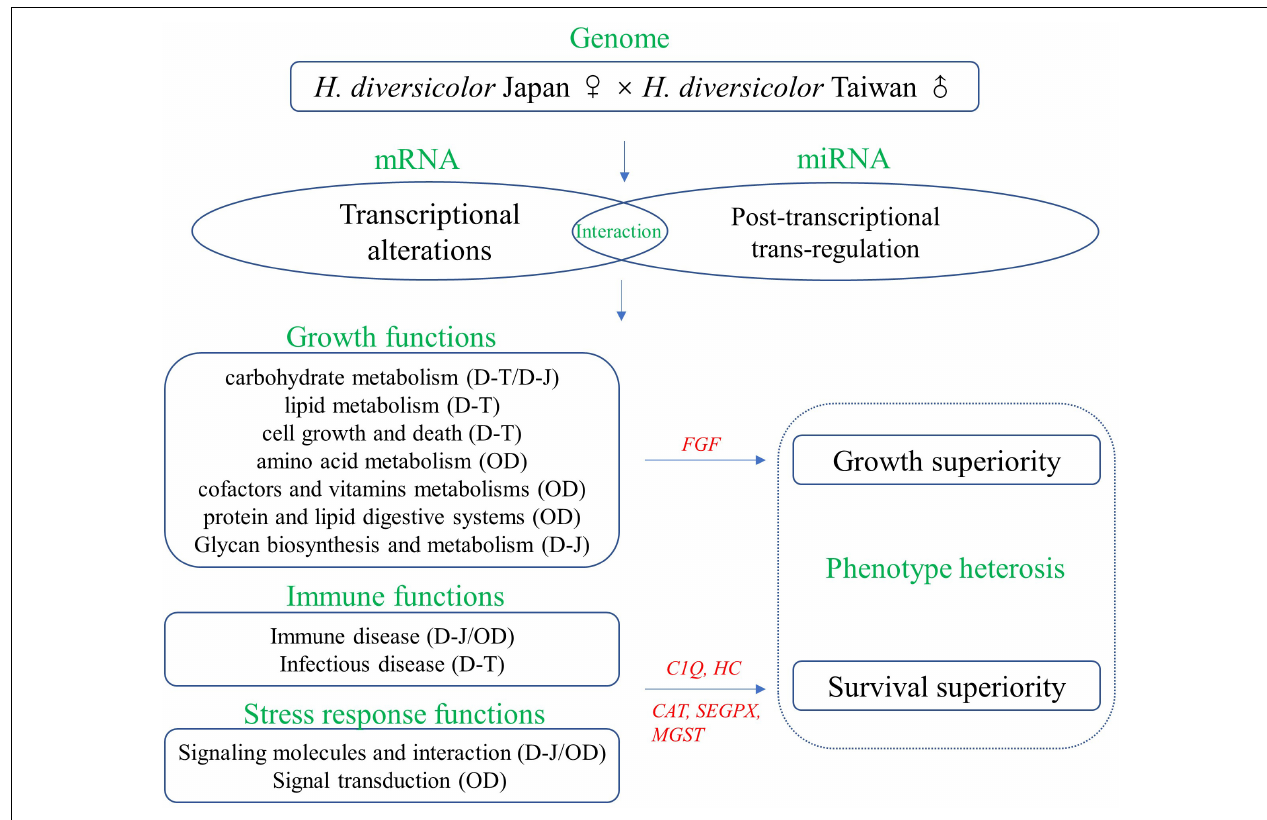
FIGURE 11 | Hypothetical model of heterosis in the hybrid H. diversicolor